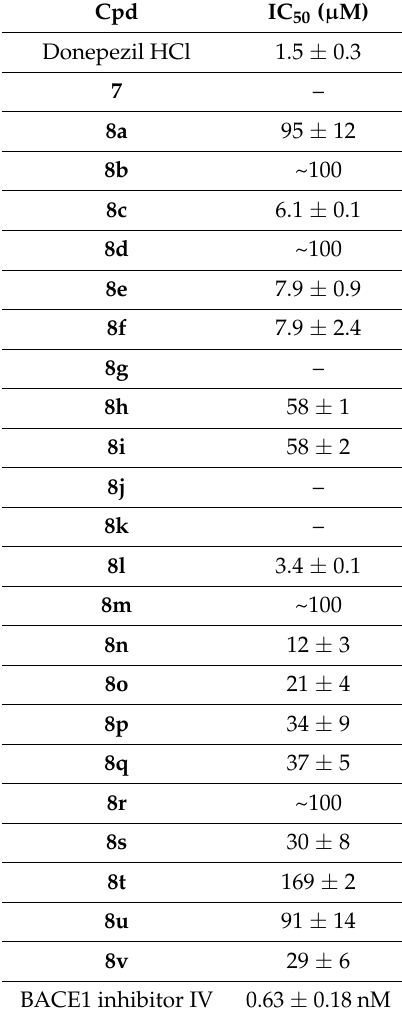
Table 3. Inhibition (IC50 values in µ M, unless otherwise noted) of the activity of BACE1 by donepezil and its analogues 7 , and 8a – v . BACE inhibitor IV was used as a